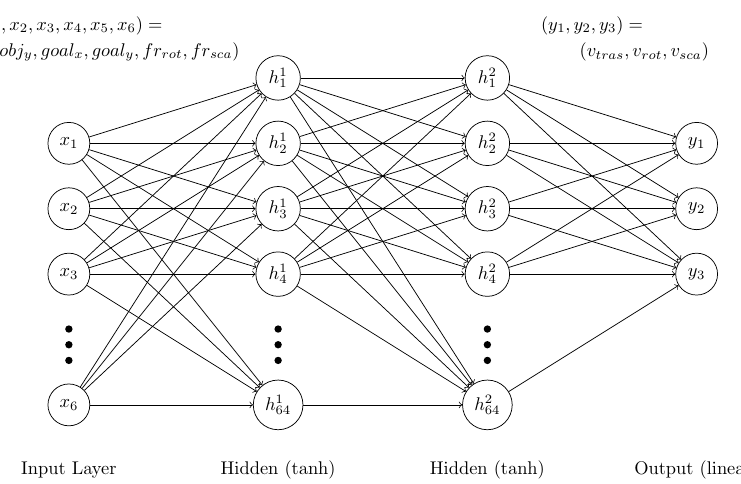
Figure 3. Deep neural network used as a model for reinforcement learning. The activation function of each neuron is shown in parentheses. The network uses the observations as inputs and the action space defined in the Markov decision process (MDP) as the